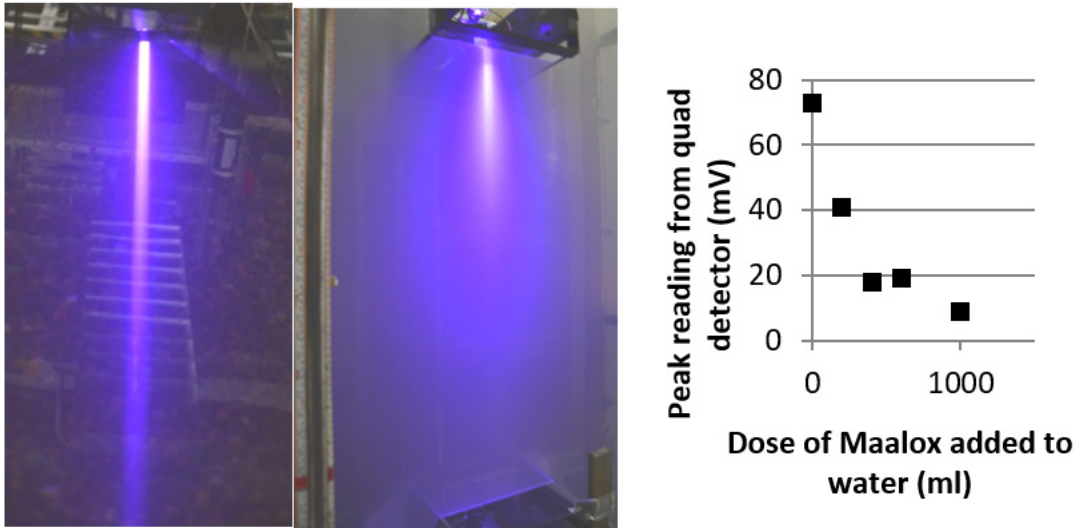
Figure 6. Laser transmission over 1 m of water with increasing scattering solution. ( Left ): Photo with a light concentration of Maalox added. ( Centre ): Very high concentration of Maalox added. ( Right ): Peak voltage reading from the quadrant detector representing received power over the underwater path length, for increasing Maalox concentration.